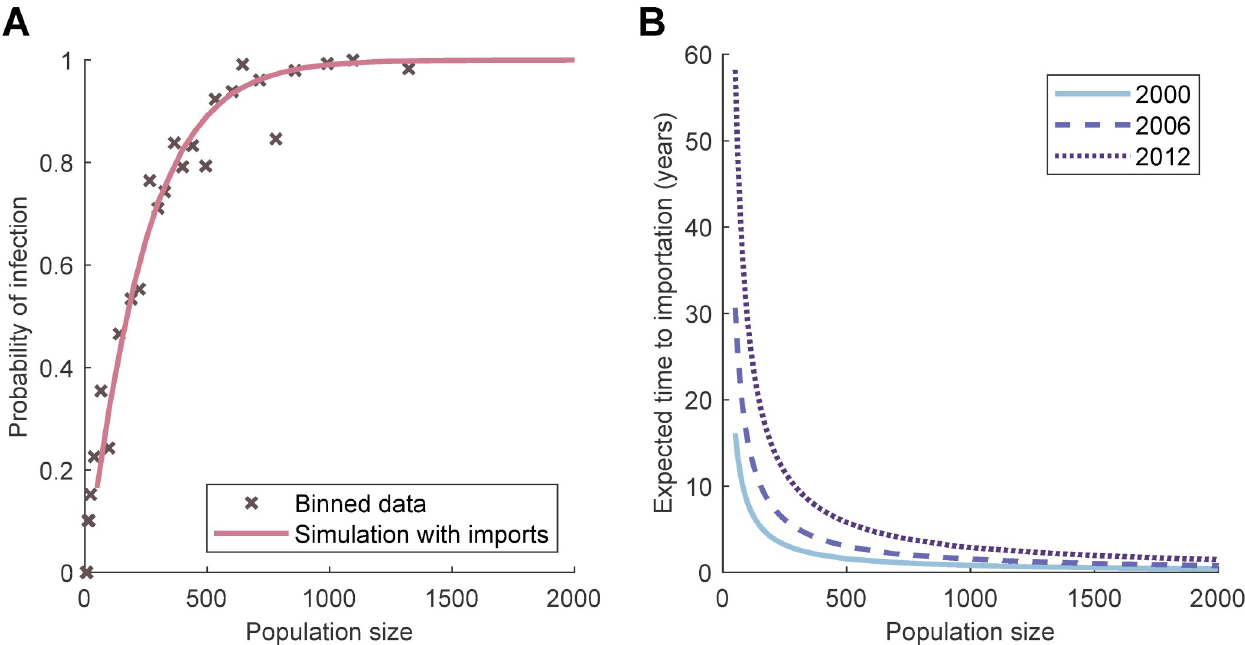
Fig 6. Simulating external importations of infection into village populations. (A) By running simulations with different values for the external infection parameter, we find the best fit—to data binned by population size from the WHO HAT Atlas on whether there are any detected cases on the first active screening—is when imports per susceptible individual are equal to 3.4 × 10 − 6 days − 1 (solid line). (B) Curves of the expected time for an external importation into a village population using the fitted importation parameter. The importation parameter is assumed to decay at the same rate as total number of cases in time in the DRC (see Fig 5 in S1